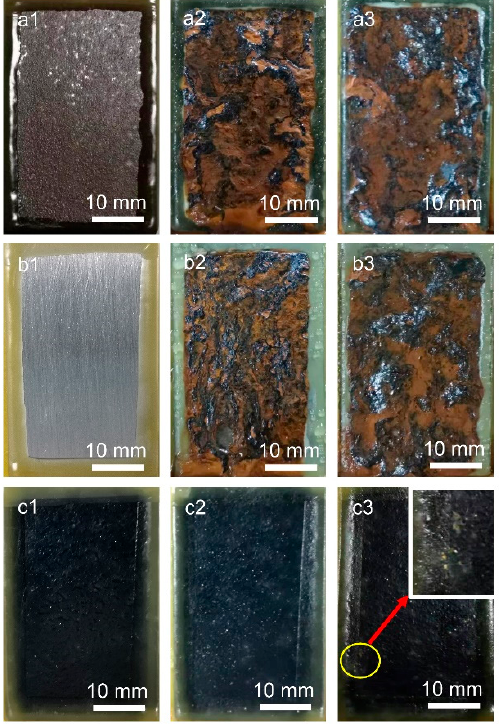
Figure 5. The surface state of the steel plates before and after rust conversion treatment under salt spray test on 1d ( a1 , b1 , c1 )—7d ( a2 , b2 , c2 )—20d ( a3 , b3 , c3 ): ( a1 – a3 ) Rusted steel with AR, ( b1 – b3 ) Bare steel, ( c1 – c3 ) RCC.